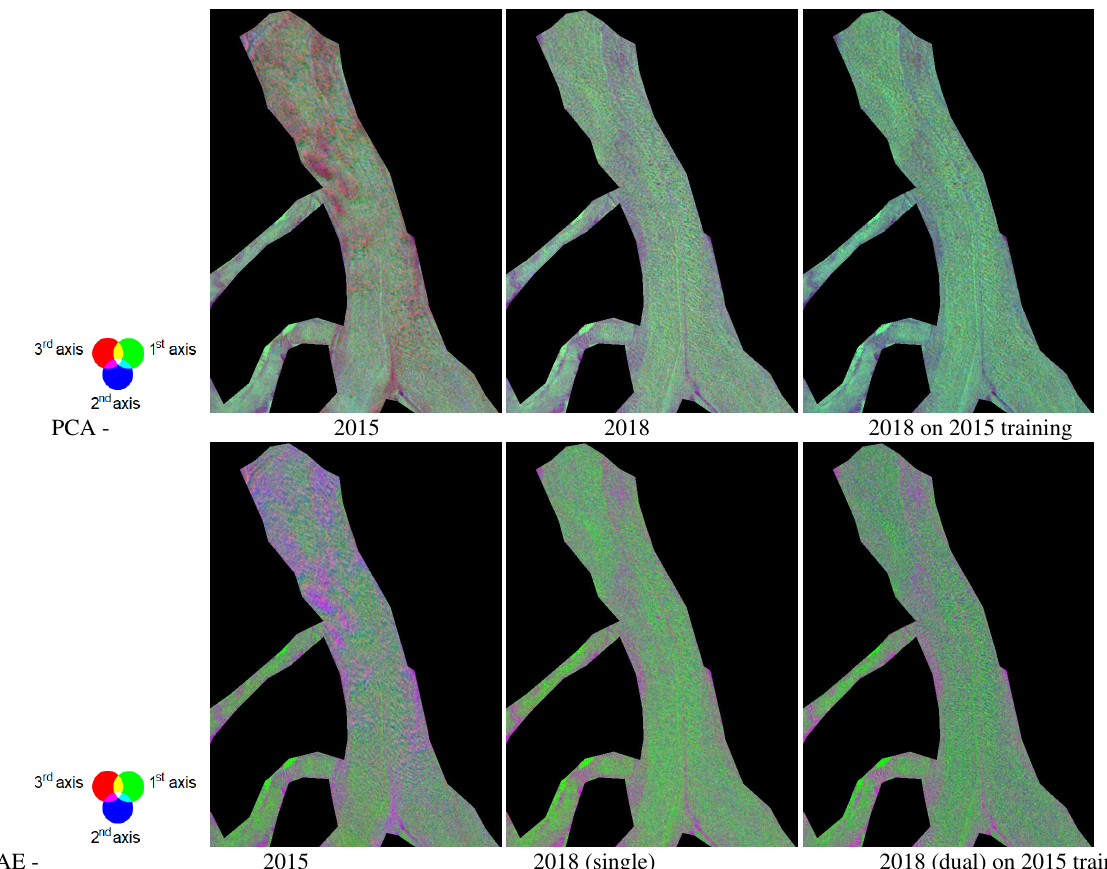
Figure 3. Left: 2015 visualization after compression on 2015, Middle: 2018 visualization after compression on 2018 (Single mode), Right: 2018 visualization after compression on 2015 (DUal mode). The first line on the Top corresponds to PCA method. The second